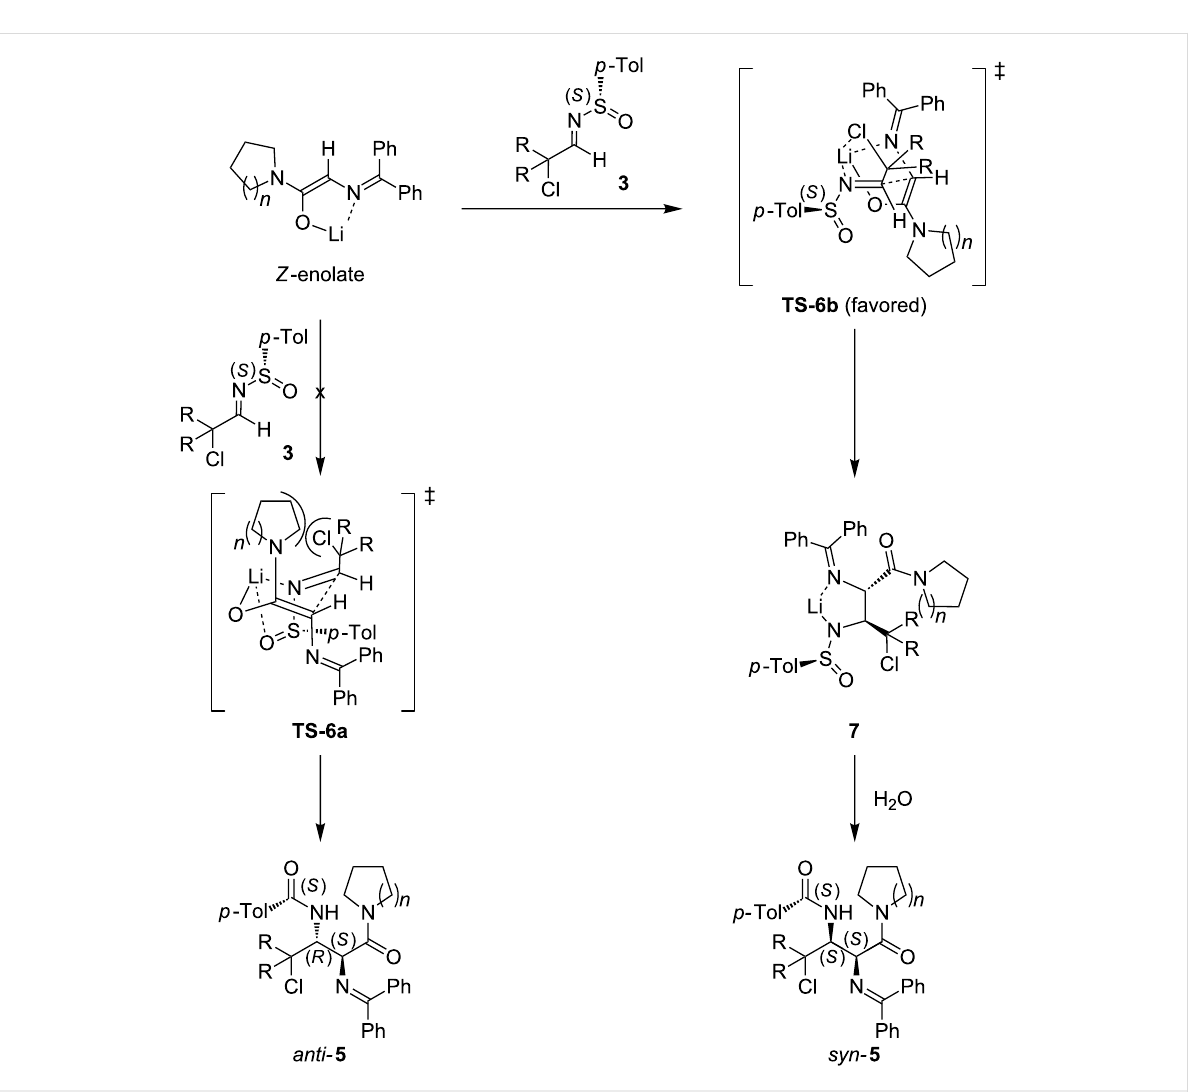
Scheme 3: Transition-state model for reaction of the Z -enolate of glycinamides 4 in the Mannich-type addition across chiral α -chloro- N - p -toluene- sulfinyl aldimines 3